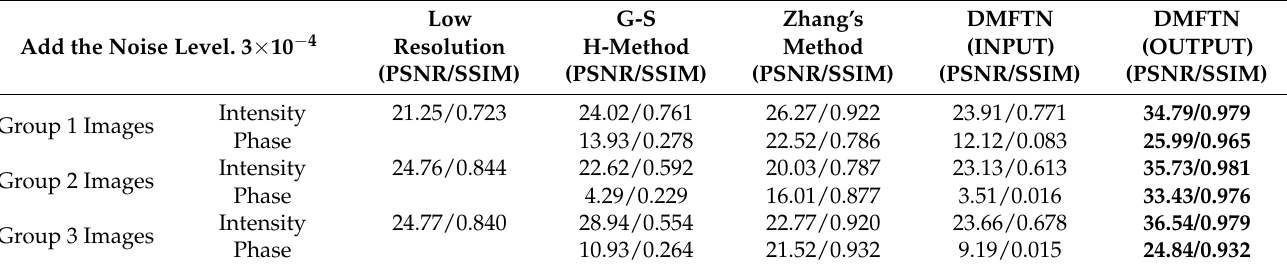
Table 1. Index values of different image reconstruction results under the same